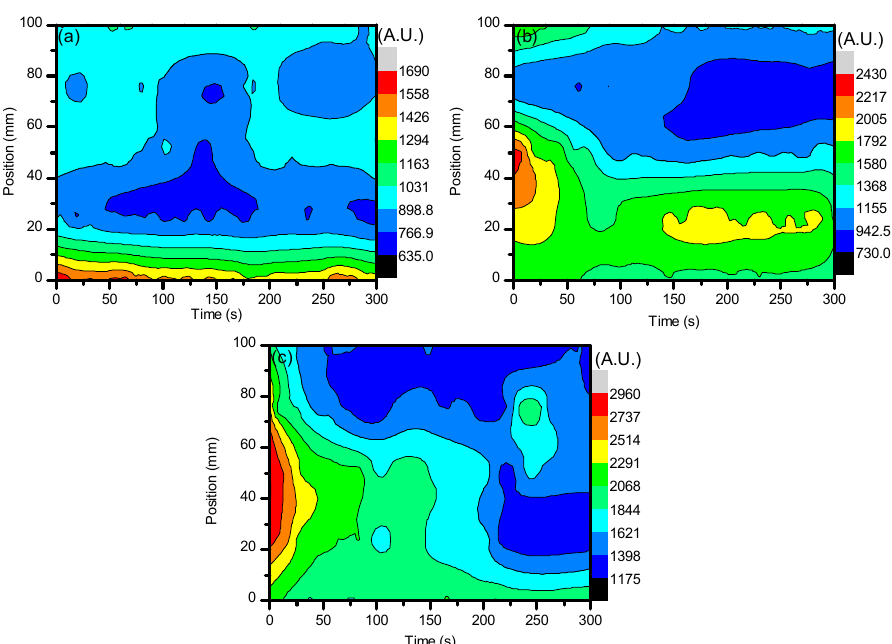
Figure 5. The above shows the spatial and temporal evolution of OH when using ambient air as the sole working gas in the plasma system. ( a – c ) represent 27 kV, 29.6 kV, and 32 kV, respectively.